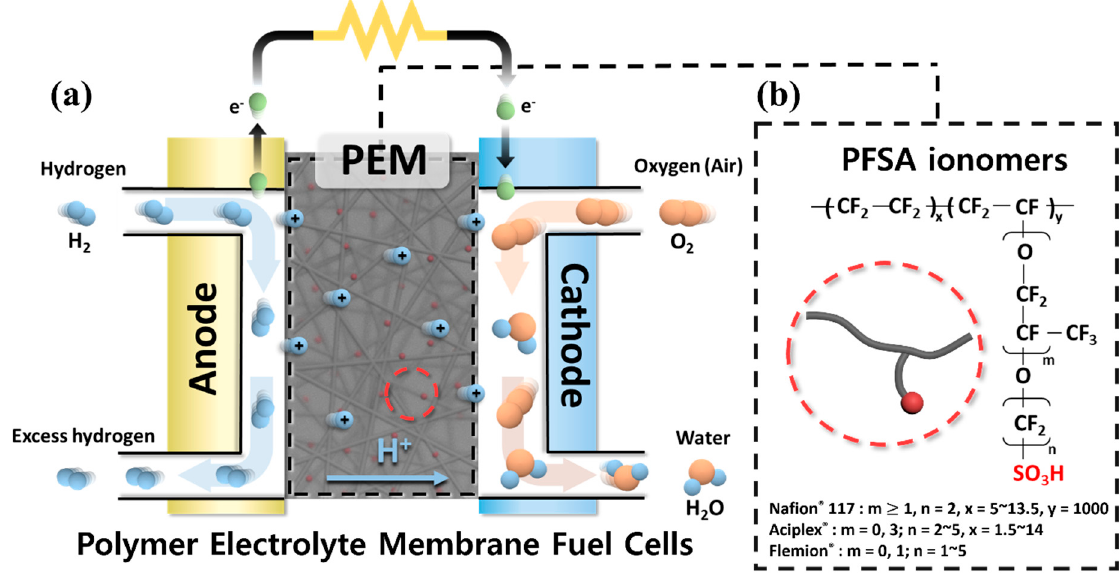
Figure 1. ( a ) Schematic diagram of polymer electrolyte membrane fuel cells. ( b ) Chemical structures of perfluorosulfonic acid ionomers.